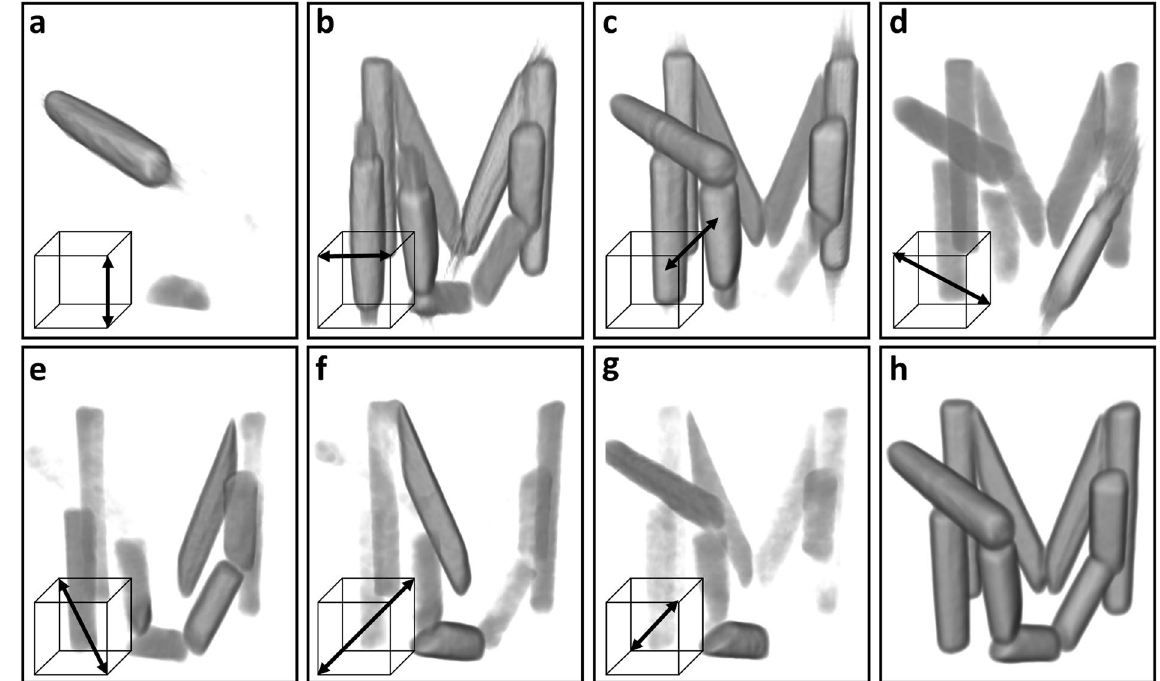
Figure 4. Reconstructions with different sensitivity directions. ( a – g ) Volume renderings of the reconstruction results for seven individual datasets after registration. For each measurement, the sample was rotated around a different axis, as indicated by the arrow in the insert. These axes were always kept perpendicular to the grating lines so a simple filtered back-projection reconstruction could be used. ( h ) The sum of all dark-field